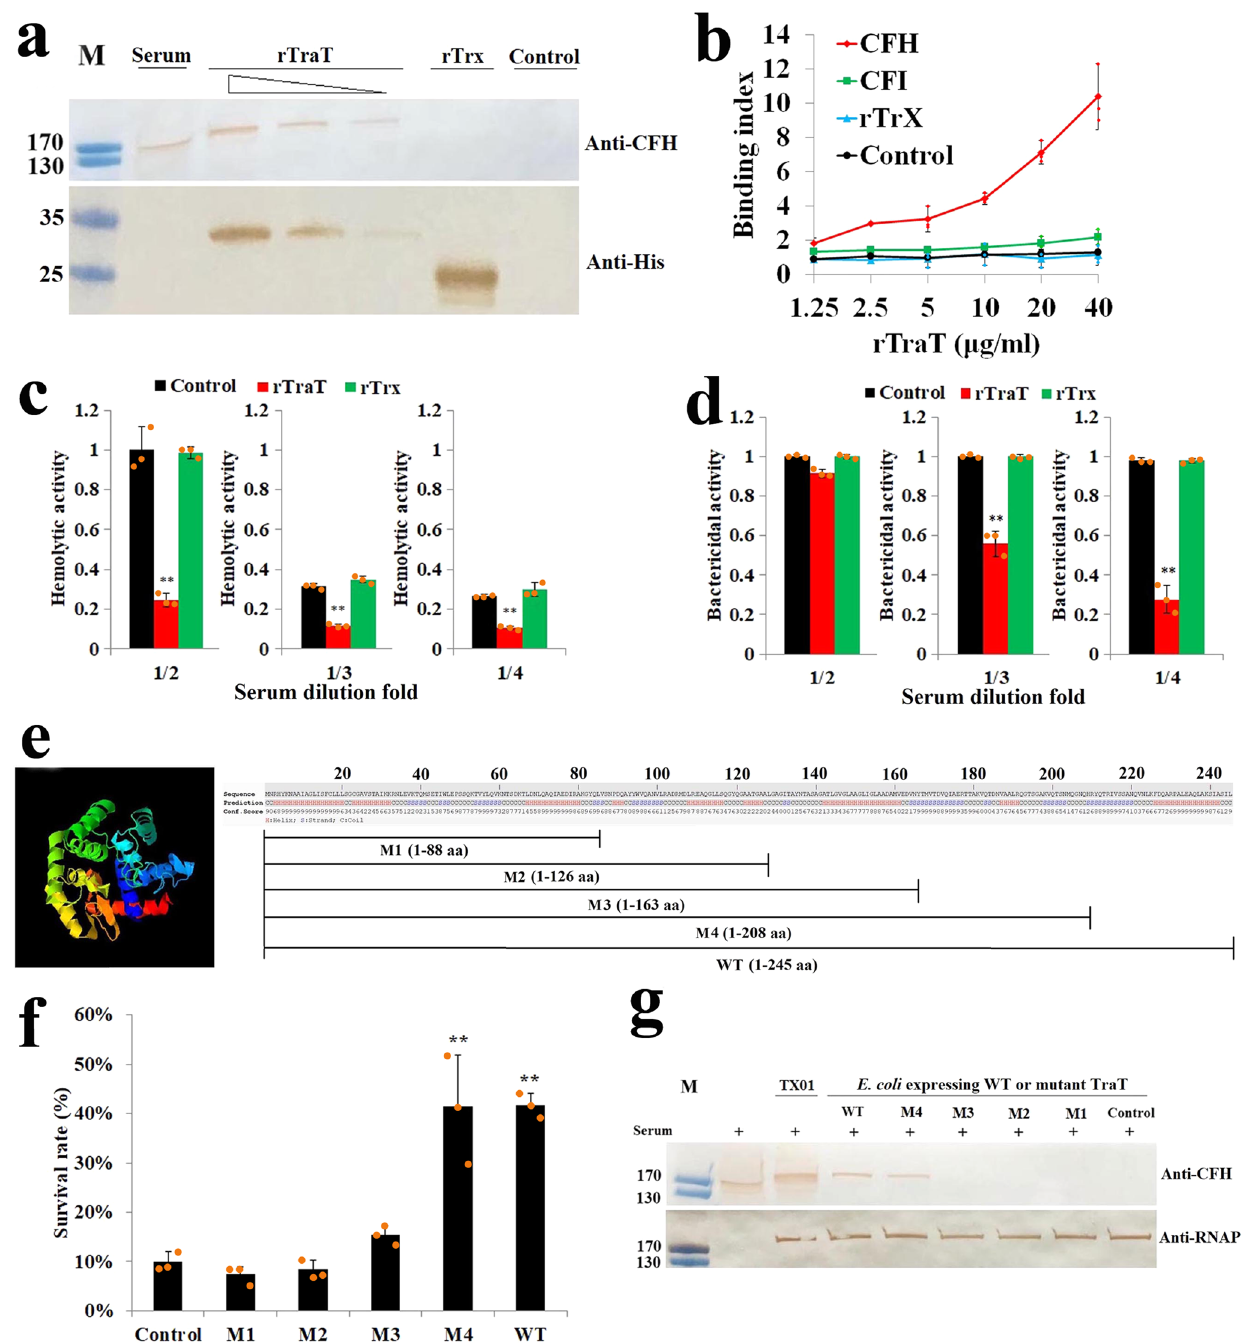
Fig. 3 rTraT affects complement activation. a Serum was incubated with or without (control) different concentrations of rTraT (20 – 80 µ g/ml) or rTrx (80 µ g/ml) and then subjected to IP with anti-His antibody. The immunoprecipitates were then blotted with anti-CFH and anti-His tag antibodies. M, molecular weight markers. b rTraT in different concentrations was incubated with or without (control) puri fi ed CFH, CFI, or rTrx (a negative protein control), and the protein bound to rTraT was determined by ELISA. c , d Serum in different dilutions was incubated with or without (control) rTraT or rTrx, and the hemolytic ( c ) and bactericidal ( d ) activities of the serum were subsequently determined. e The 3D structure of TraT and the schematic drawings of TraT wild type (WT) and mutants (M1 to M4). f E. coli expressing or not expressing (control) TraT wild type (WT) and mutants (M1 to M4) were treated with serum for 1 h, and bacterial survival was determined. g The E. coli variants of ( f ) as well as TX01 were treated with serum and determined for CFH binding by western blot with RNAP as a loading control. M, molecular weight markers. In panels b – d , and f , the data are the means of three independent experiments and presented as means ± SEM. ** P <